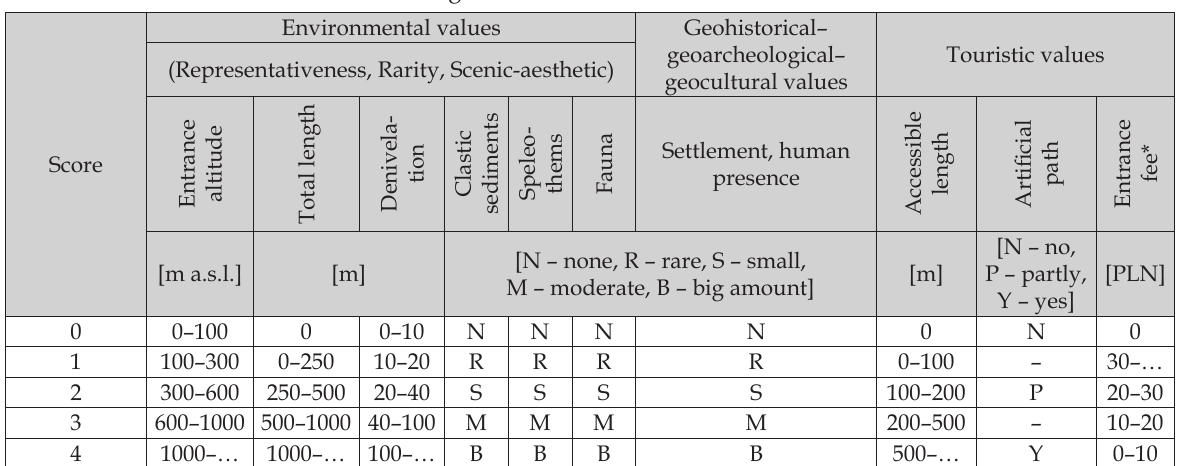
Table 3. Assigned scores for cave attraction